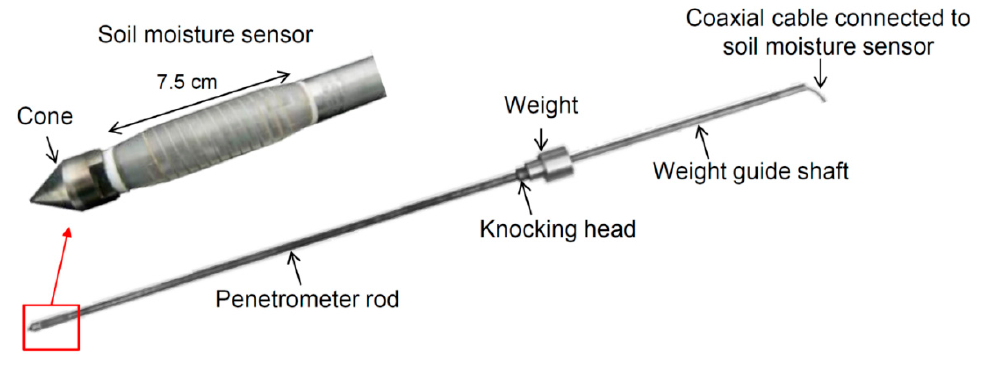
Figure 2. Photograph of the combined penetrometer–moisture probe (CPMP).